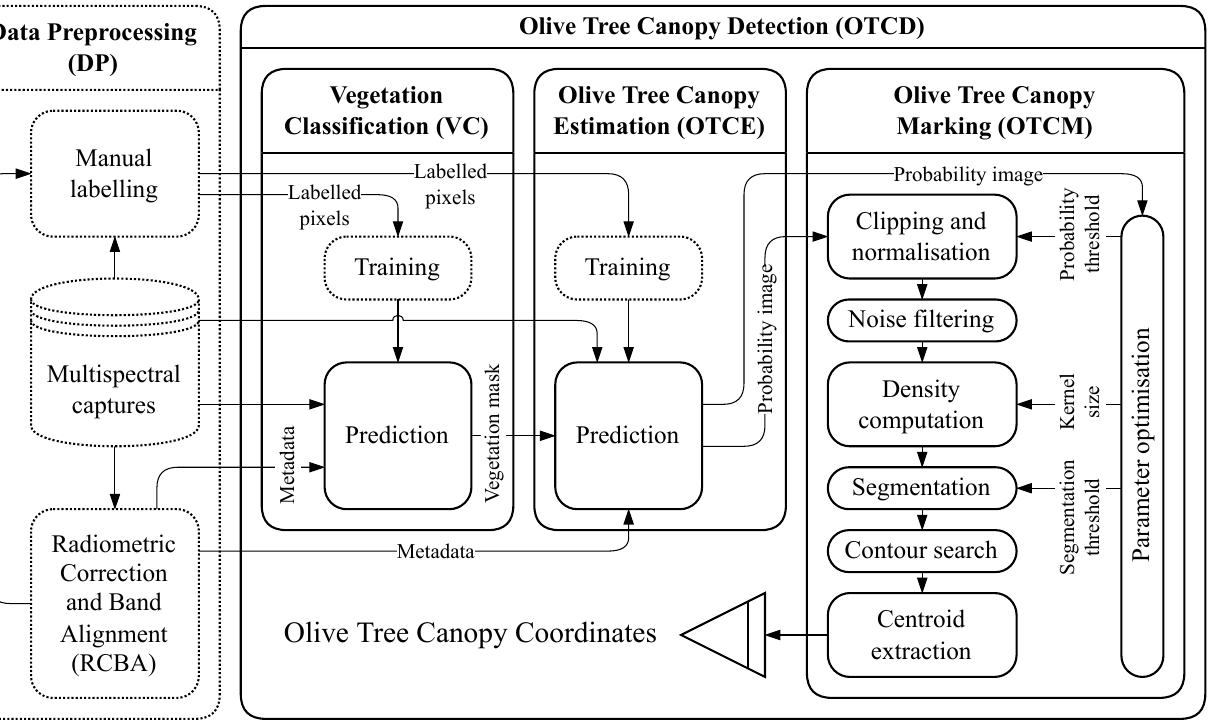
Figure 1. Workflow of the method proposed in this paper. The arrows represent data transfers, and the nodes represent functions that are applied to that data. As exceptions, the initial node, Multispectral Captures , represents the data acquired by the UAV and the final node, Olive Tree Canopy Coordinates , represents the most optimal coordinates that the model is capable of predicting. Blocks with dotted outlines represent tasks that are performed